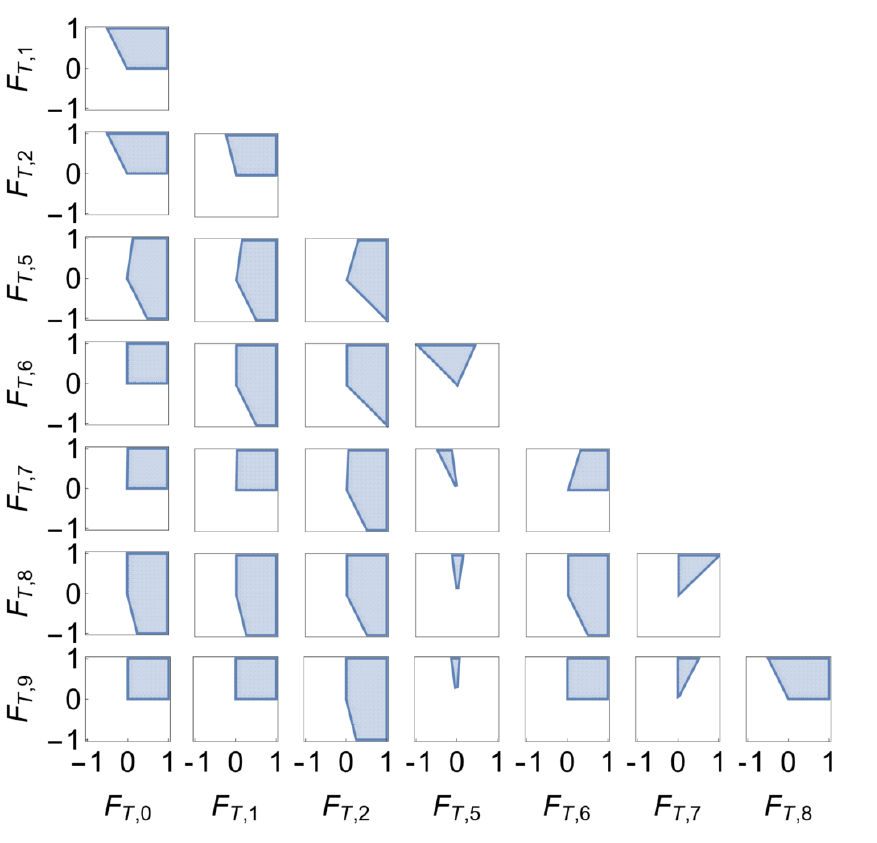
Figure 22 . Positivity constraints on all F T;i